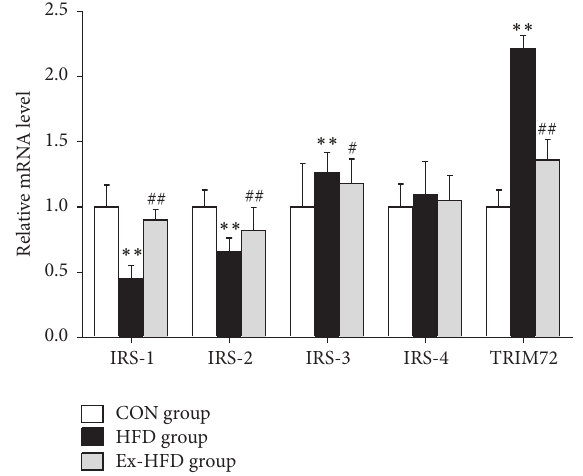
Figure 3: Effect of swimming exercise on mRNA expression of IRS- 1 and TRIM72 in skeletal muscle. Data are presented as mean ± SD. For each group 𝑛 = 10 . IRS-1: insulin receptor substrate-1, IRS-2: